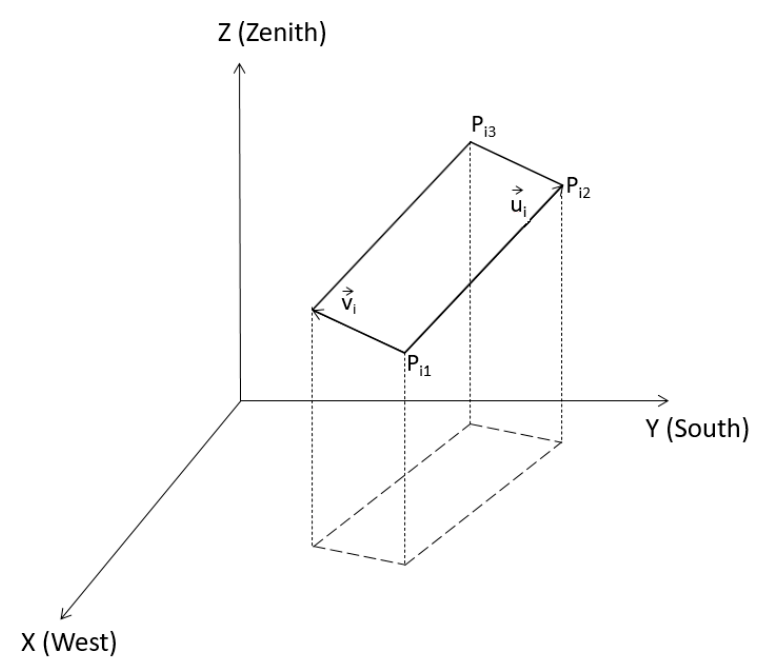
Figure 2. Geometric representation of a manifold of index i from its vertices P i 1 , P i 2 , and P i 3 . → u i and v i must be perpendicular to each other, so Equation (7) must be